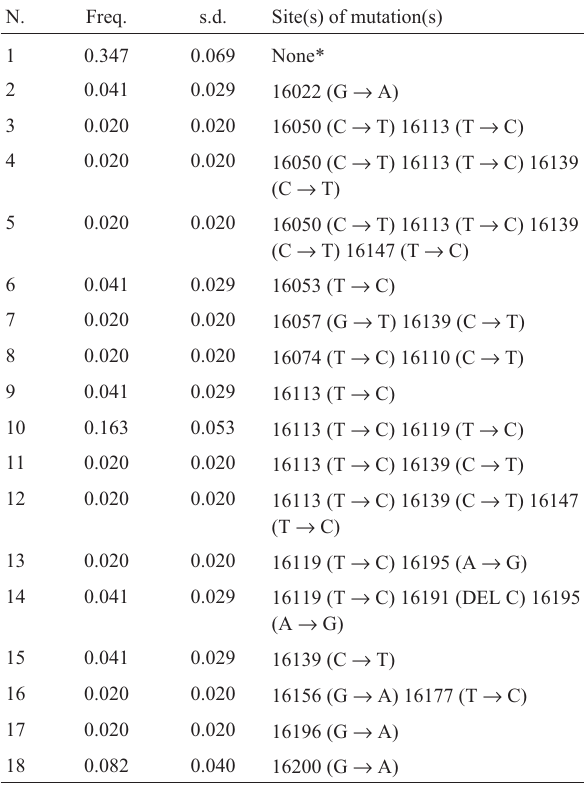
Table 2 - Haplotype frequencies in a Brangus-Ibagé cattle population. N.